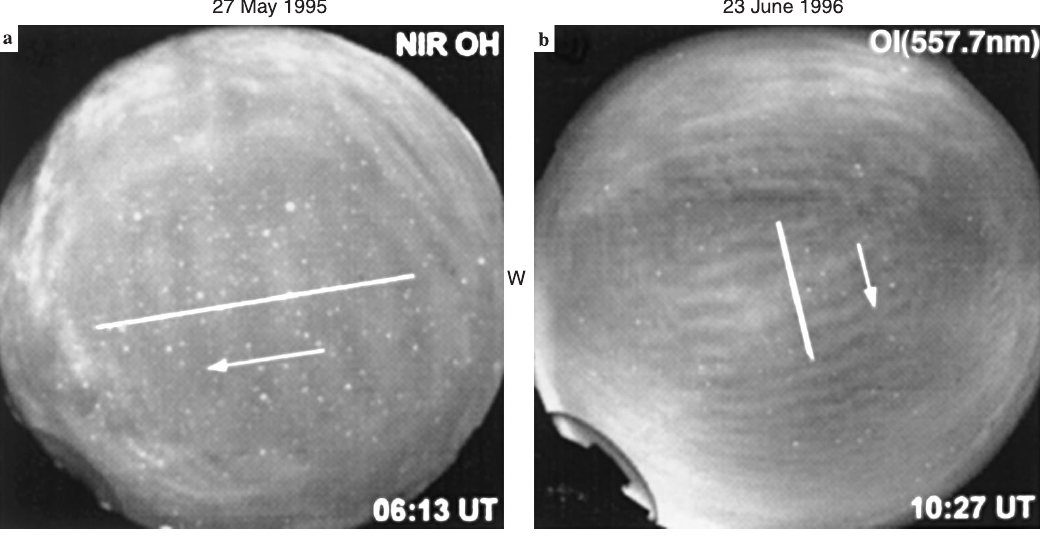
Fig. 1a, b. Examples of nightglow images from Bear Lake Observa- tory, Utah (41.6 (cid:14) N, 111.6 (cid:14) W), portraying propagating gravity waves. The periods, horizontal wavelengths, phase speeds and propagation azimuths are a 13.5 min, 26 km, 32 m/s and 85 (cid:14) , and b 5.2 min,